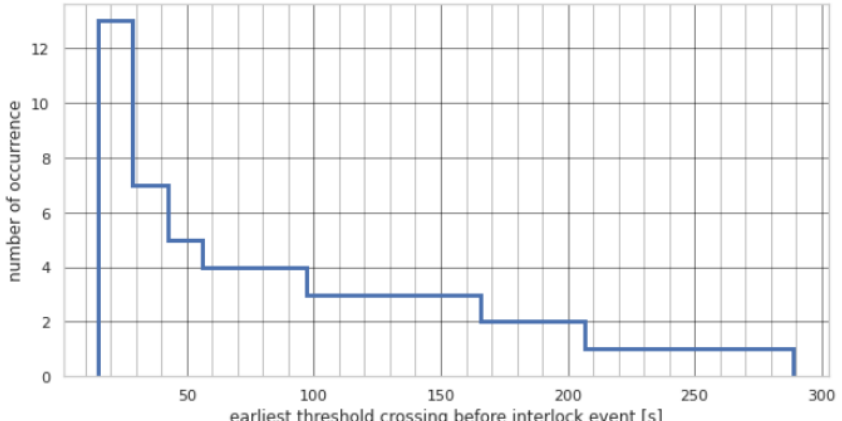
Figure 13. Reverse cumulative histogram of the first instance the alarm threshold was crossed before an interlock event and the model prediction values remained above the threshold. From evaluation of the ROC curve, a threshold value of 0.65 is chosen. Displayed are the results for the best-performing RPCNN model. Please note that the interlock event is at 0 s, i.e., time runs from right to